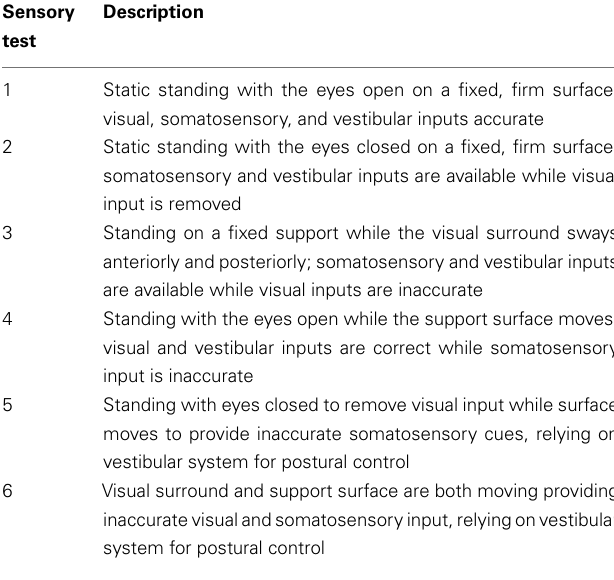
Table 1 | Test conditions for computerized dynamic